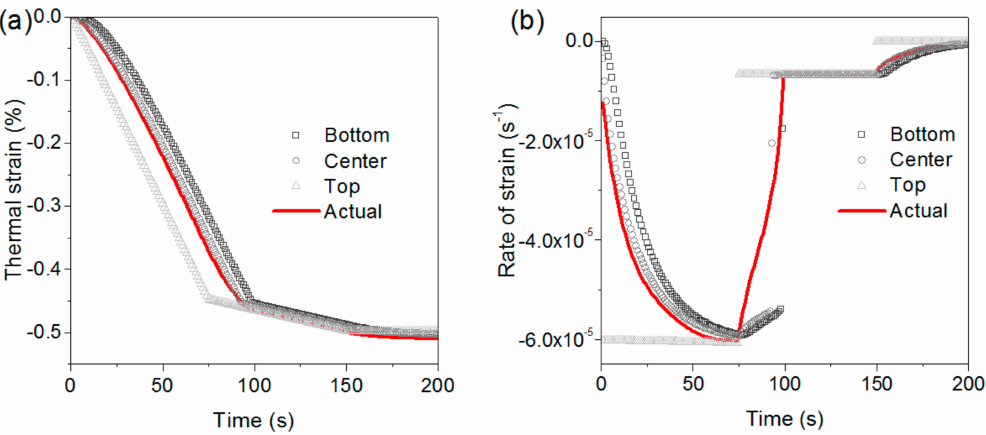
Figure 15. Difference between ideal shrinkage and actual shrinkage. ( a ) Ideal thermal strain at different positions and actual strain; and ( b ) the ideal rate of strain and actual rate of